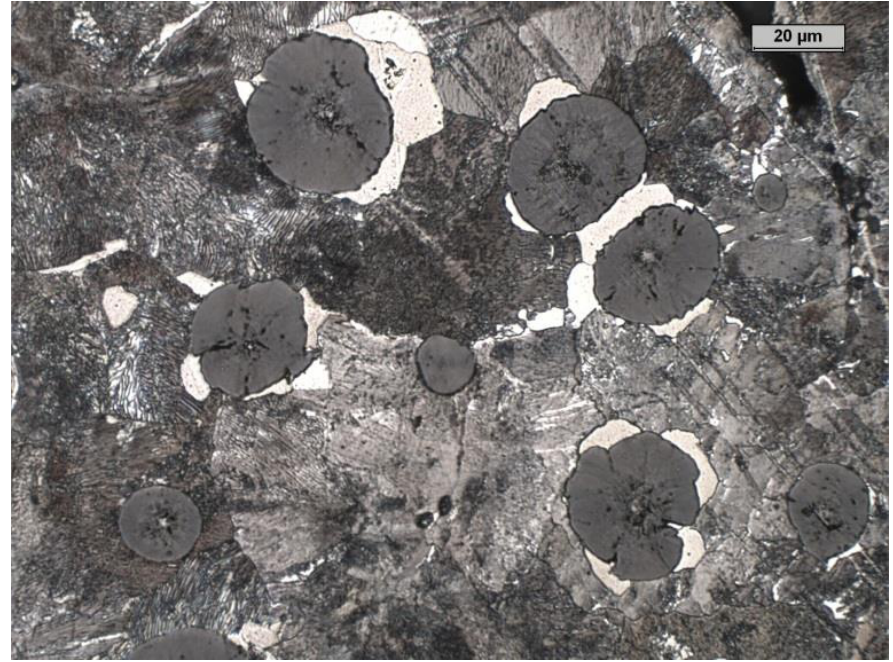
Figure 3. The etched microstructure of the investigated cast iron.